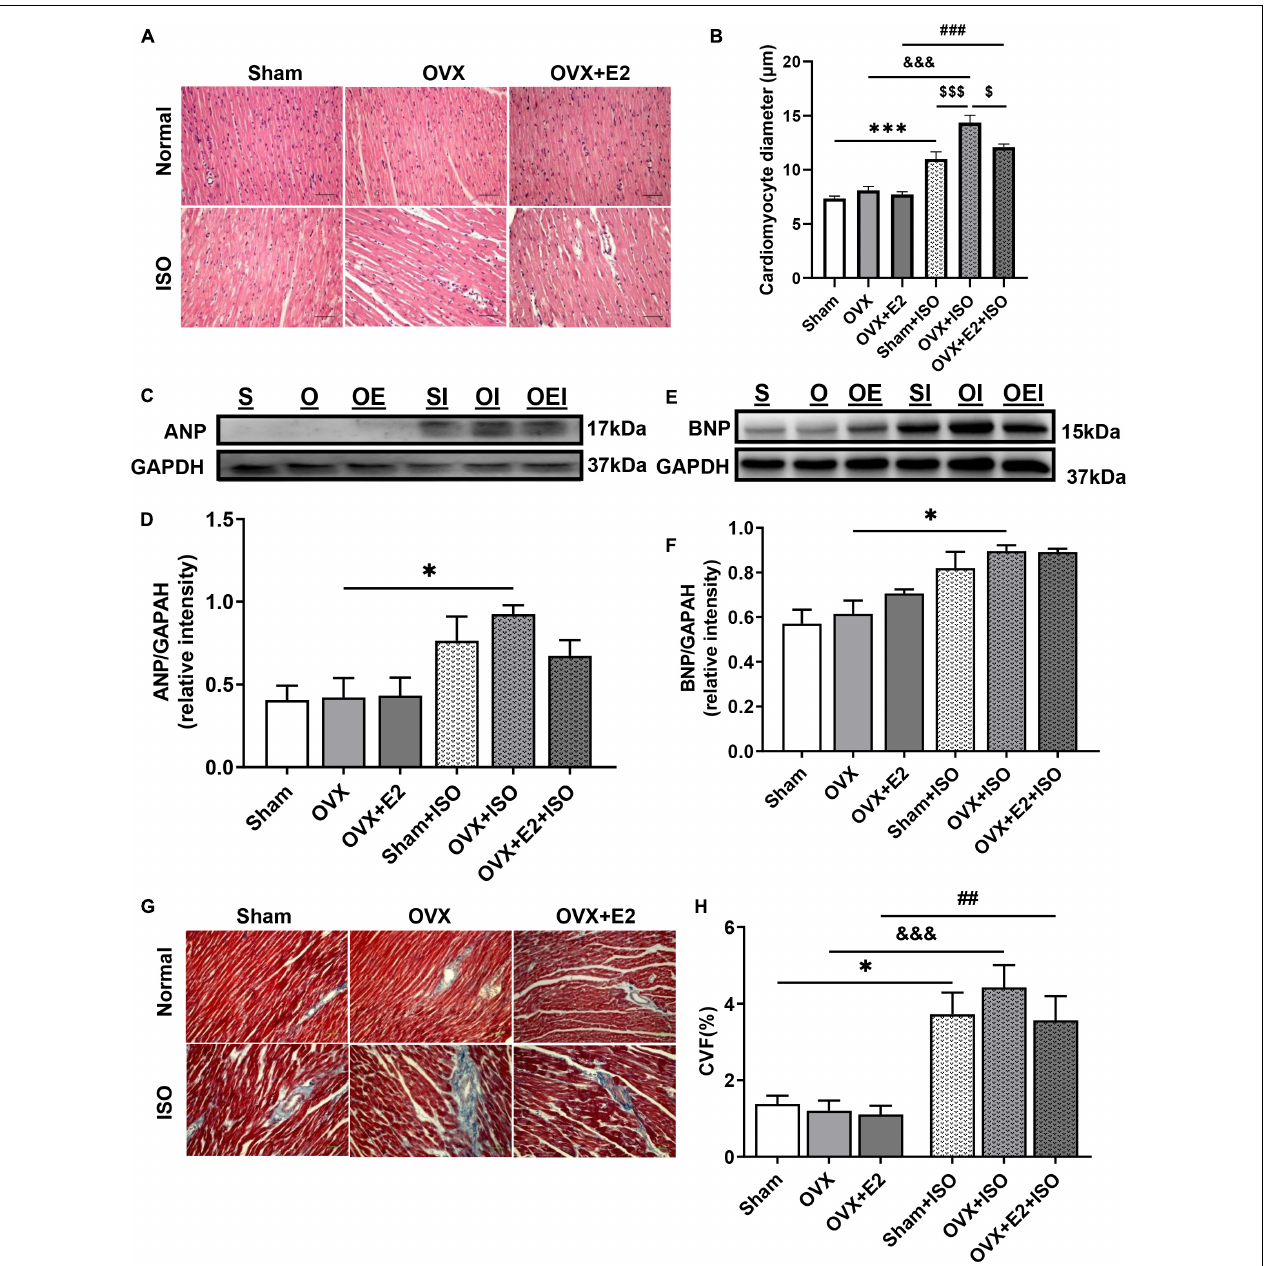
FIGURE 3 | Estrogen deficiency promotes myocardial hypertrophy and fibrosis during chronic stress. (A,B) Representative H&E staining and graphical presentation of measured cardiomyocyte diameters, respectively ( n = 10–12 cells/5 field of view/6–8 sections/6 hearts/group). (C–F) Representative immunoblots and graphical presentations of assessed cardiac hypertrophy markers, atrial natriuretic peptide (ANP), and brain natriuretic peptide (BNP) ( n = 4 hearts/group). (G,H) Representative Masson’s trichrome staining and graphical presentation of evaluated collagen volume fractions to assess the extent of fibrosis ( n = 5–7 field of view/6–8 sections/6 hearts/group). ∗ p < 0.05 and ∗∗∗ p < 0.001; ## p < 0.01 and ### p < 0.001; $ p < 0.05 and $$$ p < 0.001; &&& p < 0.001. Data are presented as mean ± SEM. Data were analyzed using two-way ANOVA and Bonferroni’s multiple comparisons